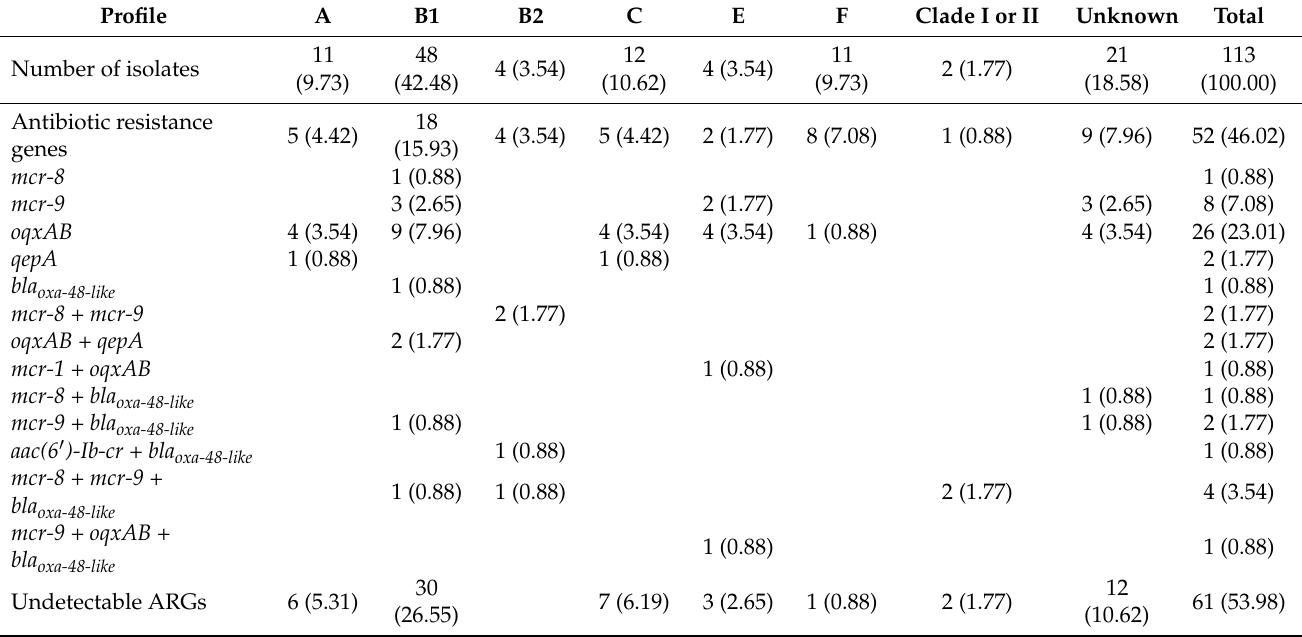
Table 4. Profiles of the antibiotic resistance genes and the antibiotic resistance of E. coli according to the phylogenetic